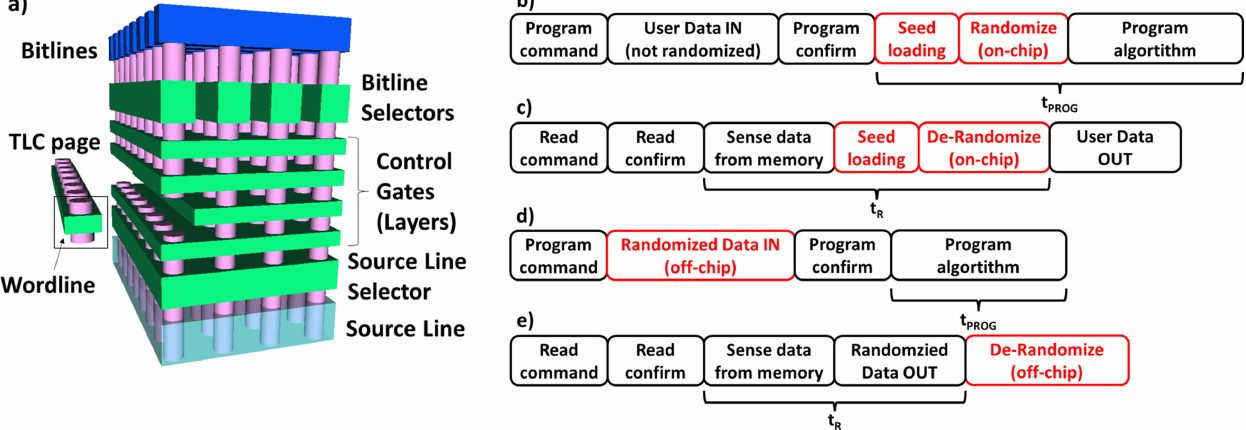
Figure 1. ( a ) The TLC 3D NAND Flash architecture. Reprinted with permission from [9] under Creative Commons License 4.0 (CC-BY). ( b ) Sequence of operations during program operation considering on-chip randomization. ( c ) Sequence of operations during read operation considering on-chip randomization. ( d ) Sequence of operations during program operation considering off-chip randomization. ( e ) Sequence of operations during read operation considering off-chip